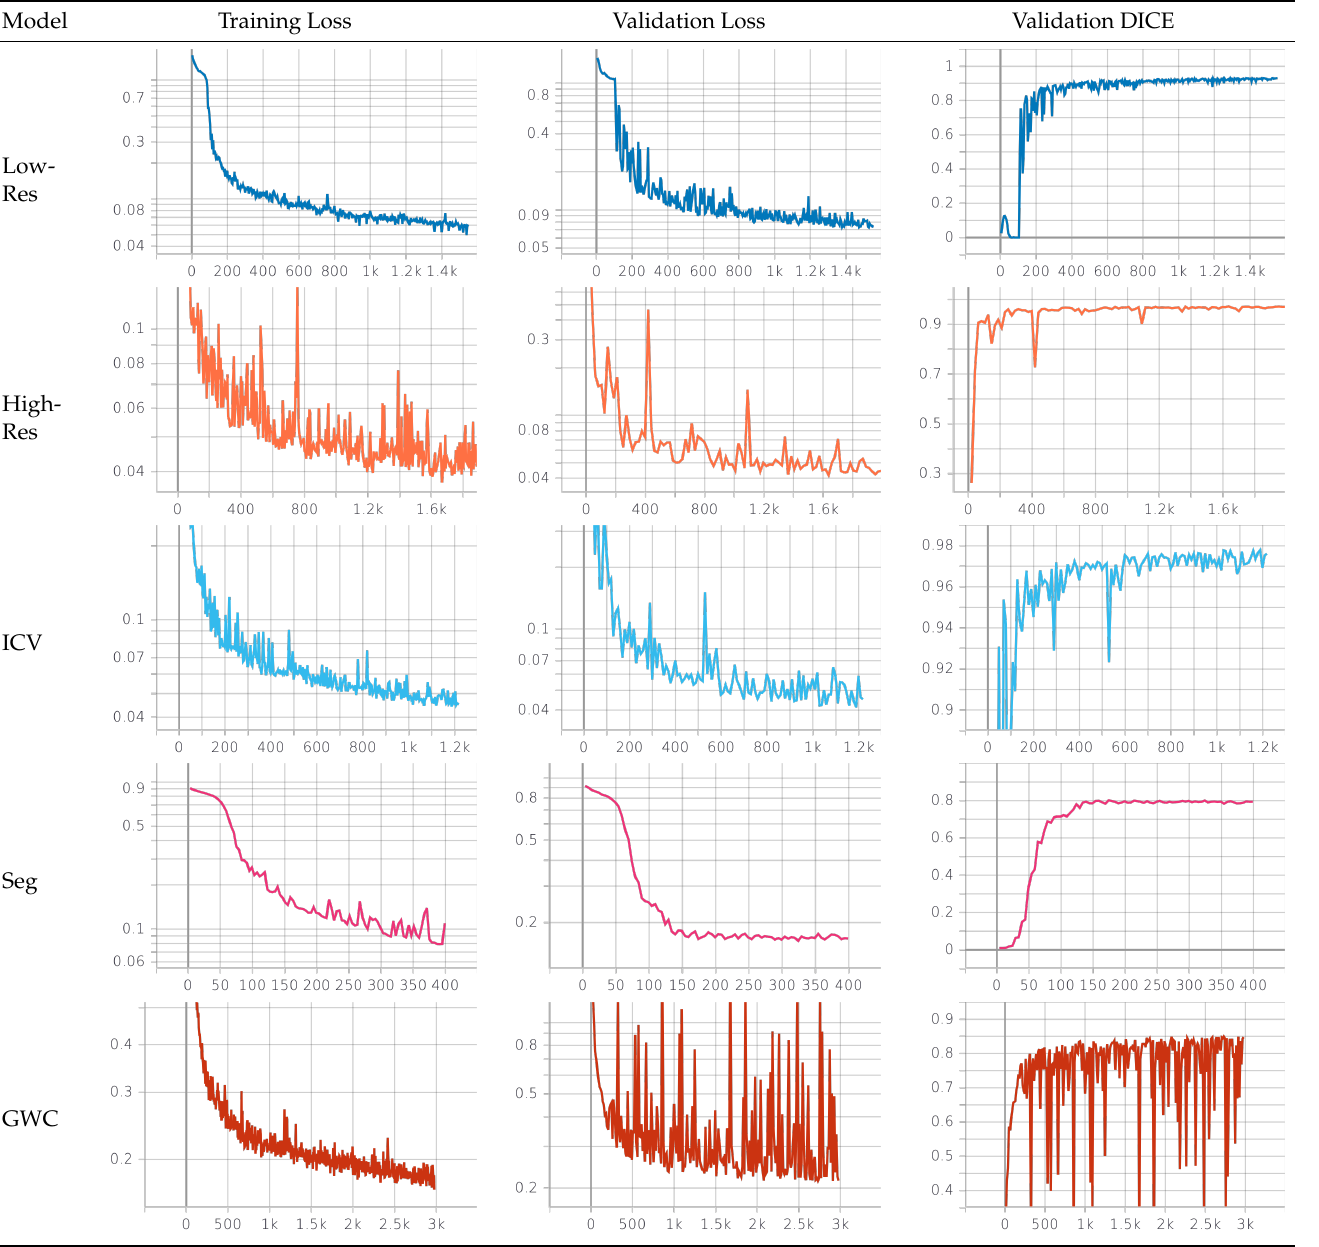
Figure 6. Training convergence curves. Training and validation losses are shown with a logarithmic scale and indicate that all models converged properly. The validation DICE curves use a linear scale and display improvement with the model convergence